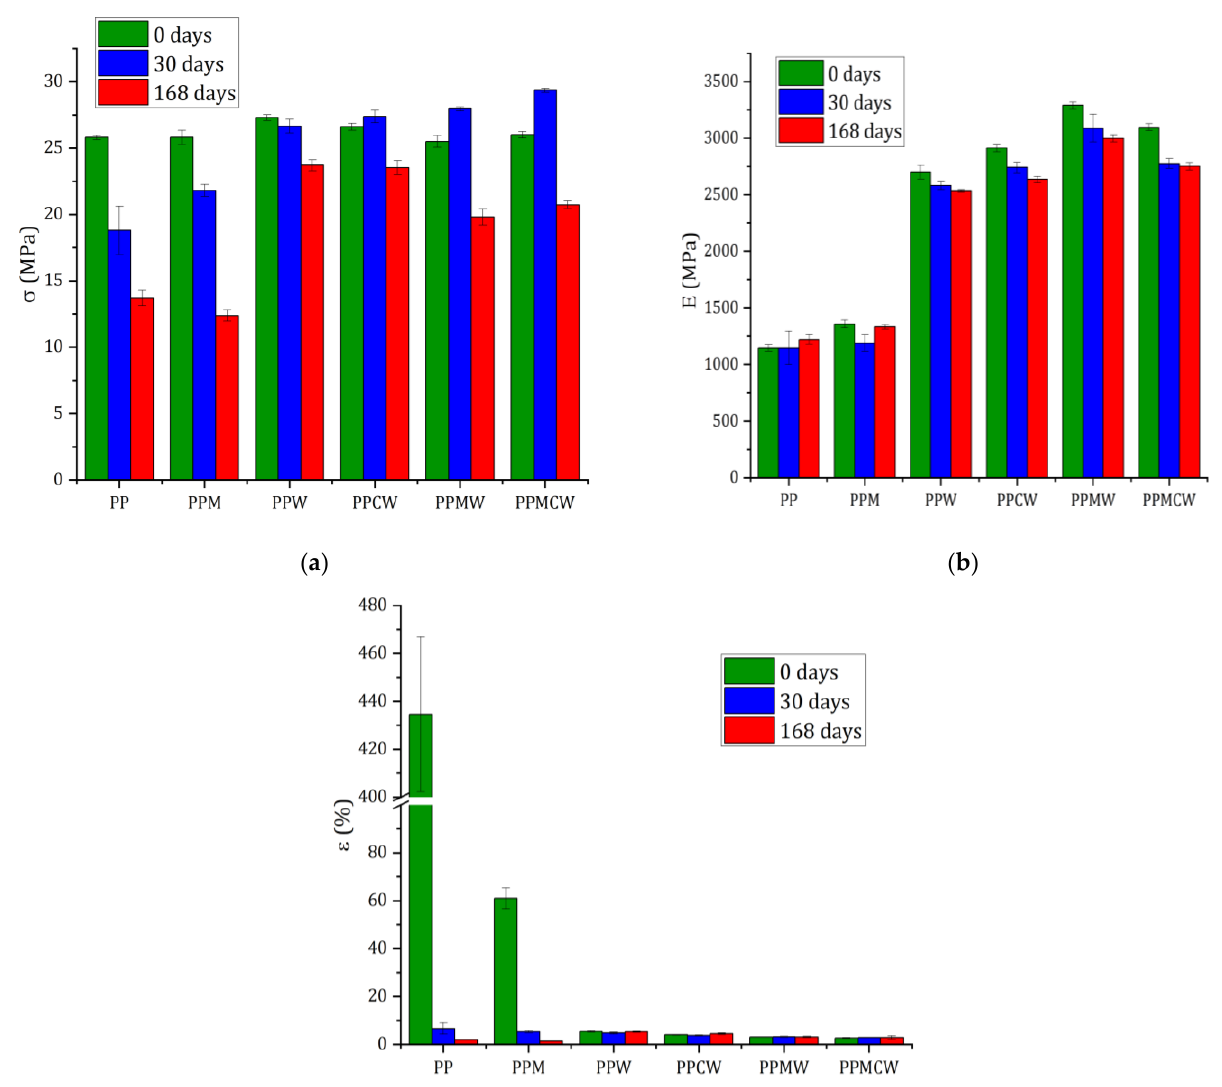
Figure 5. ( a ) Yield stress ( σ ), ( b ) elastic modulus (E), and ( c ) deformation at break ( ε ) of samples before (0 days), after natural (168 days), and accelerated (30 days) aging.